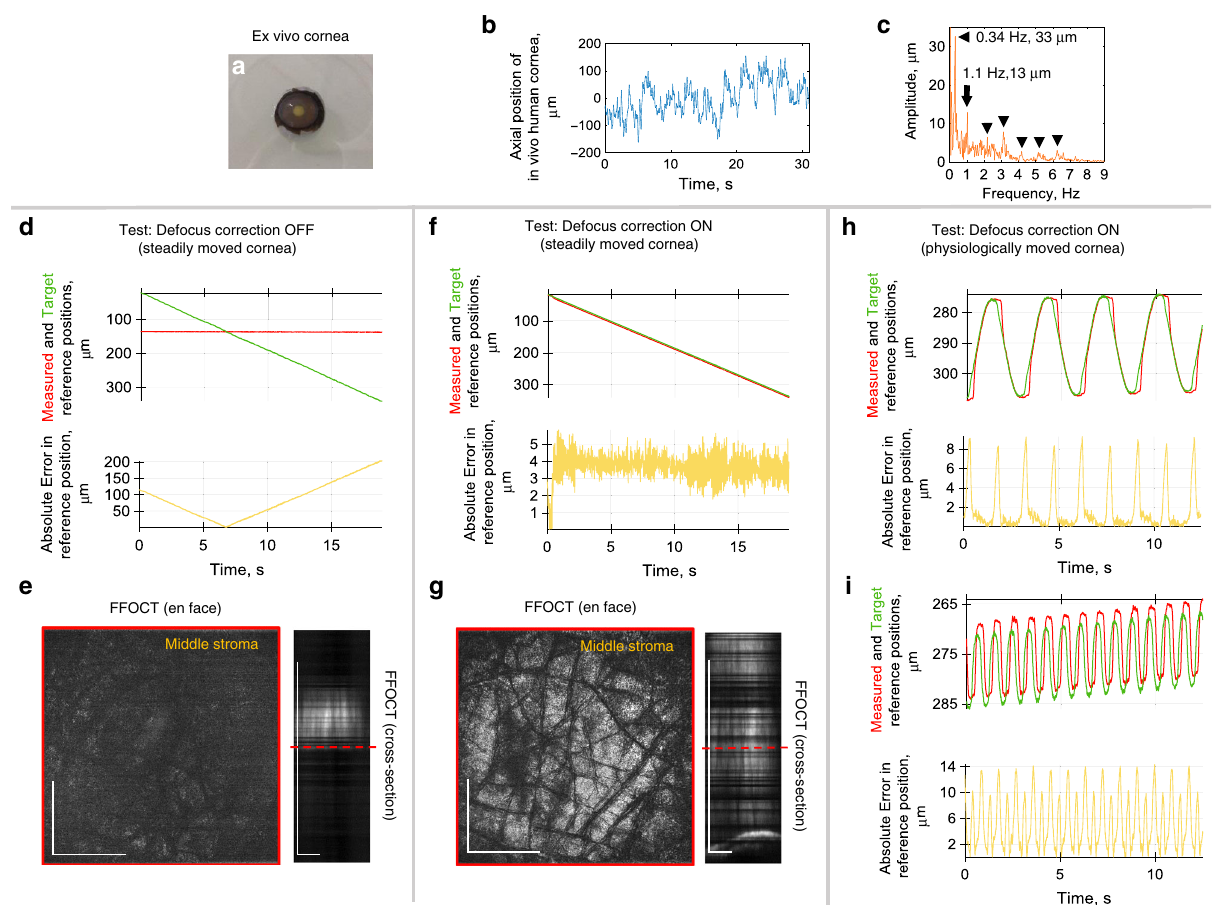
Fig. 4 Validating the real-time defocusing correction on an ex vivo cornea, driven by the motorized stage. a Photo of the corneal sample (without motor mount). Sample had visible stromal striae, indicative of tissue stress 49 . b Axial position of the in vivo human cornea over time, measured with SDOCT. c Extracted amplitudes and frequencies of the in vivo human corneal axial movements. d Steadily moved ex vivo cornea with deactivated defocus correction. Plots with measured reference mirror position (red), required reference location for ideal defocus correction (green) and error between the two (yellow). e Corresponding en face FFOCT and (reconstructed) cross-sectional FFOCT images. Red line shows location of en face FFOCT image. Without defocus correction, the reference arm position was fi xed and FFOCT images were visible only at a single corneal position within the objective ’ s depth of focus, where the optical path lengths of the interferometer arms match. f Steadily moved ex vivo cornea with active defocus correction. Small positioning error of 3.7 ± 0.8 µ m (mean ± s.d.) was estimated from 2104 positions acquired over 19 s. g FFOCT images are consistently acquired from various depths, while only occasionally the signal vanishes due to the additional phase introduced to the tomographic signal by unwanted mechanical vibrations, caused by external factors (e.g., an underground metro passing nearby) (Supplementary Movie 4). h Test of defocusing correction with ex vivo cornea mimicking the physiological ocular displacement at 0.34 Hz and 33 µ m amplitude. Positioning error of 1.5 ± 2.2 µ m (mean ± s.d.), estimated from 1157 positions acquired over 12.4 s. i Test of defocusing correction with ex vivo cornea, moved at physiological 1.1 Hz and with 13 µ m amplitude (Supplementary Movie 5). Positioning error is 5.3 ± 4.0 µ m (mean ± s.d.), estimated from 1502 positions acquired over 12.5 s. The source data underlying plots in b – d , f , h , i are provided as a Source Data fi le. Experiments were reproduced several times using the same ex vivo cornea. All scale bars are 400 µ